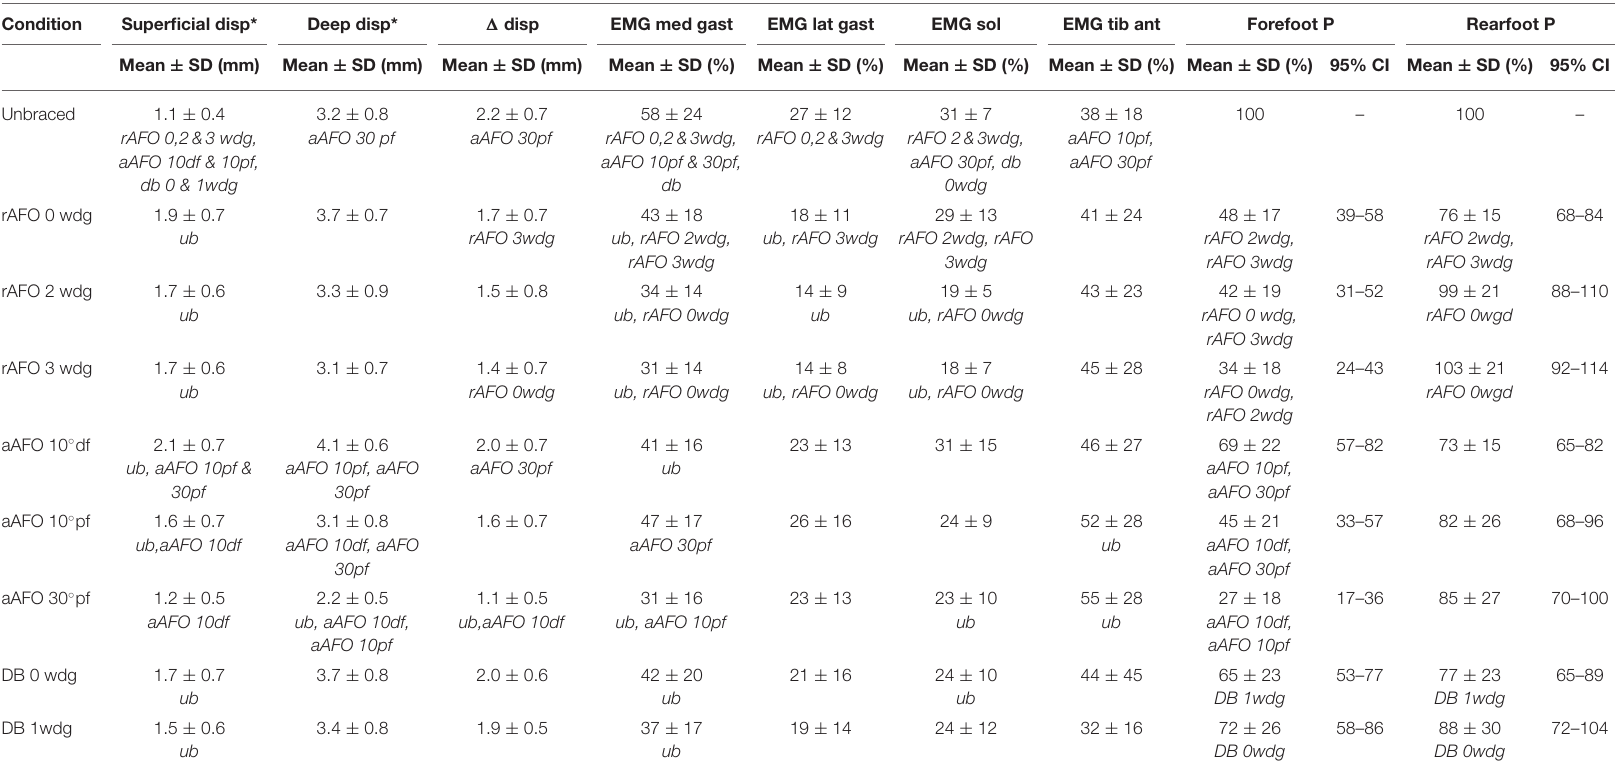
EMG is normalized to mean peak EMG during unbraced running at 10 km/h. Statistical differences between conditions are shown in italics (p < 0.05). disp, displacement; 1 disp, differential displacement; P, pressure, normalized to pressure during unbraced walking at 2 km/h. ub, unbraced; rAFO, rigid AFO; aAFO, adjustable AFO; db, dorsal brace; wdg, wedges; df, dorsiflexion; pf, plantarflexion. * Mean peak displacement in the deep parts of the tendon was significantly larger than in superficial parts for all walking conditions (p <